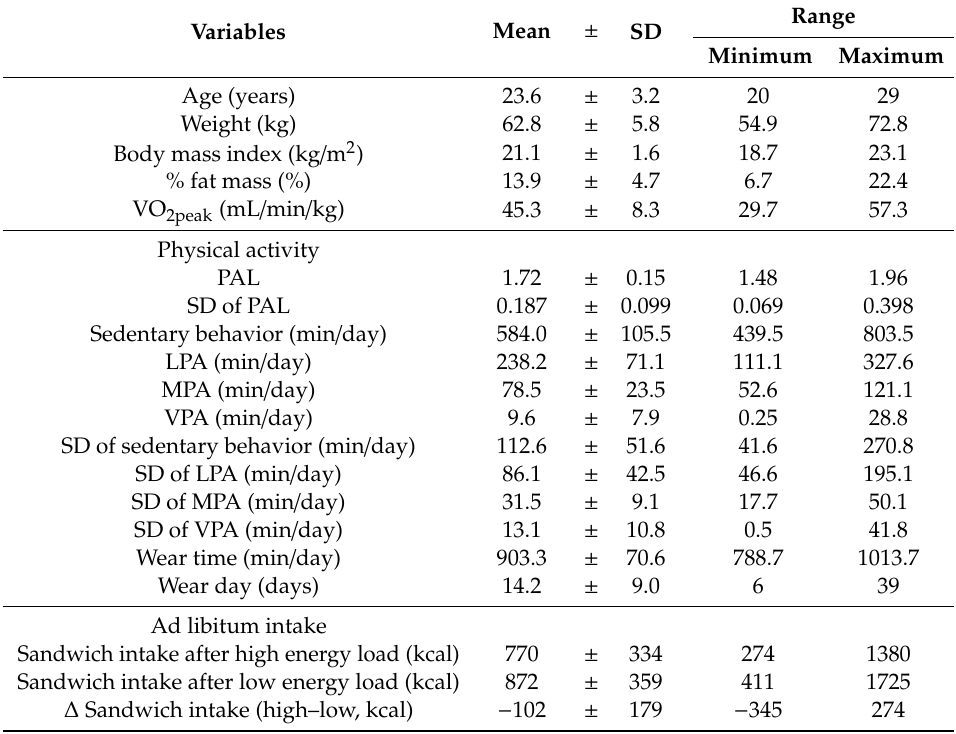
Table 2. Subject characteristics and results of physical activity and ad libitum